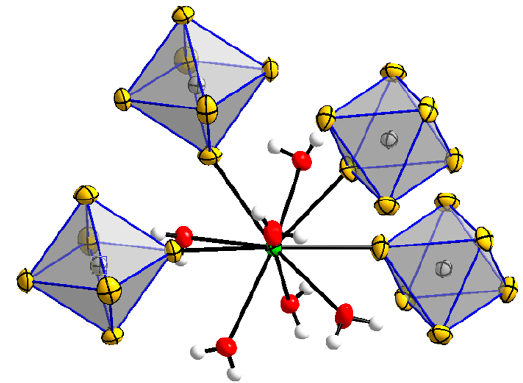
Figure 12. Fragment of the crystal structure of Ba(OsF 6 ) 2 ∙ 6H 2 O showing the coordination of OsF 6 − and H 2 O around Ba 2+ . Displacement ellipsoids are shown at 70% probability level at 100 K. All non-hydrogen atoms are shown anisotropic, hydrogen atoms are shown with arbitrary radii.